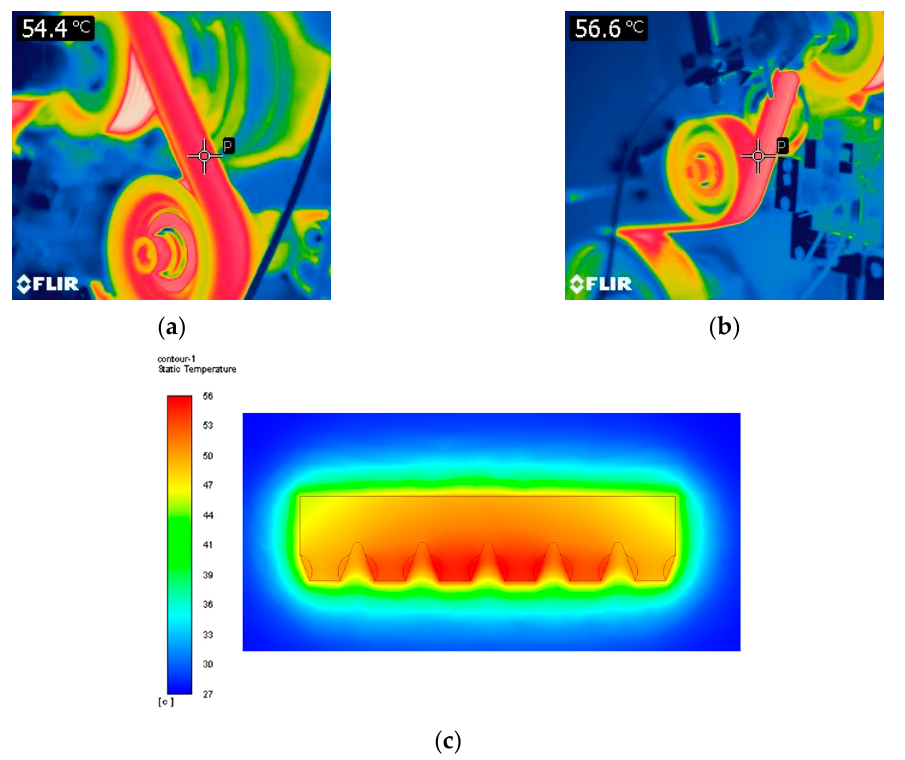
Figure 3. Nearly uniform temperature distribution of the belt: temperature at the ( a ) back and ( b ) front sides of the belt. ( c ) Temperature distribution obtained in the numerical simulation.